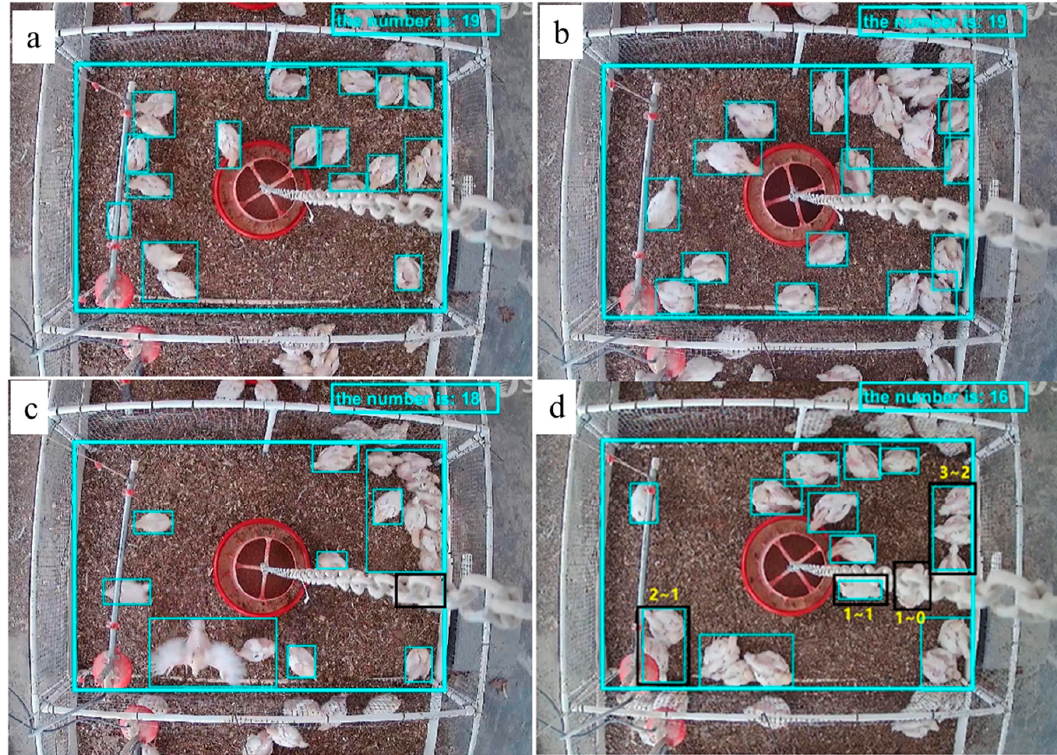
Figure 7. Number of chickens identified and their distribution determined with the newly developed BP model (chickens were three weeks of old in ( a ), ( b ) and 4 weeks old in ( c ), ( d ); cyan rectangles represent target extraction zone by BP method, and back rectangles represent missed target area (chicken); yellow numbers indicate true chicken number and behind indicate BP model recognized chicken).